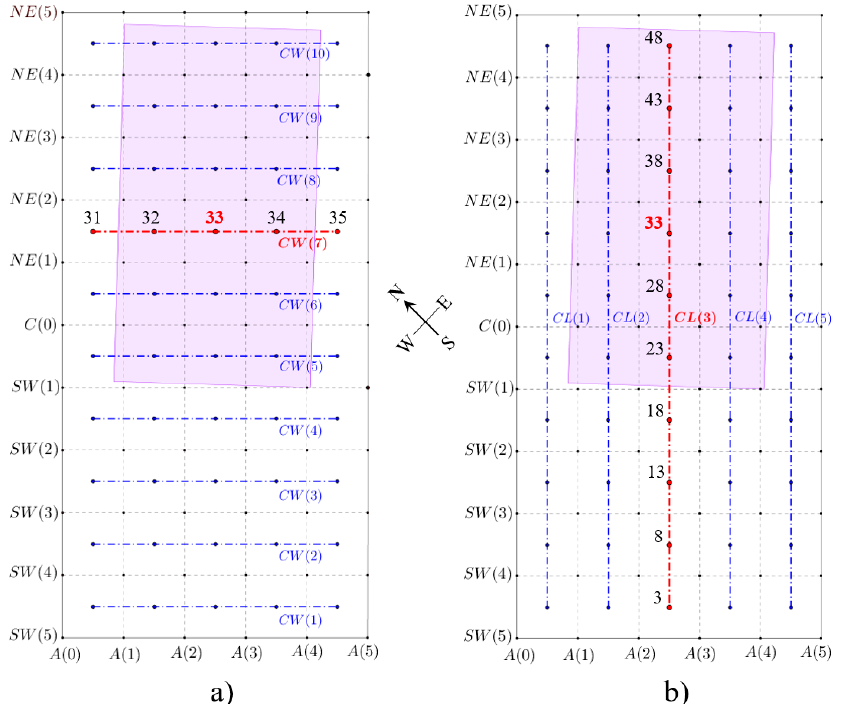
Figure 7. Layout of the defined profiles across width ( a ) and length ( b ) in the observation area.